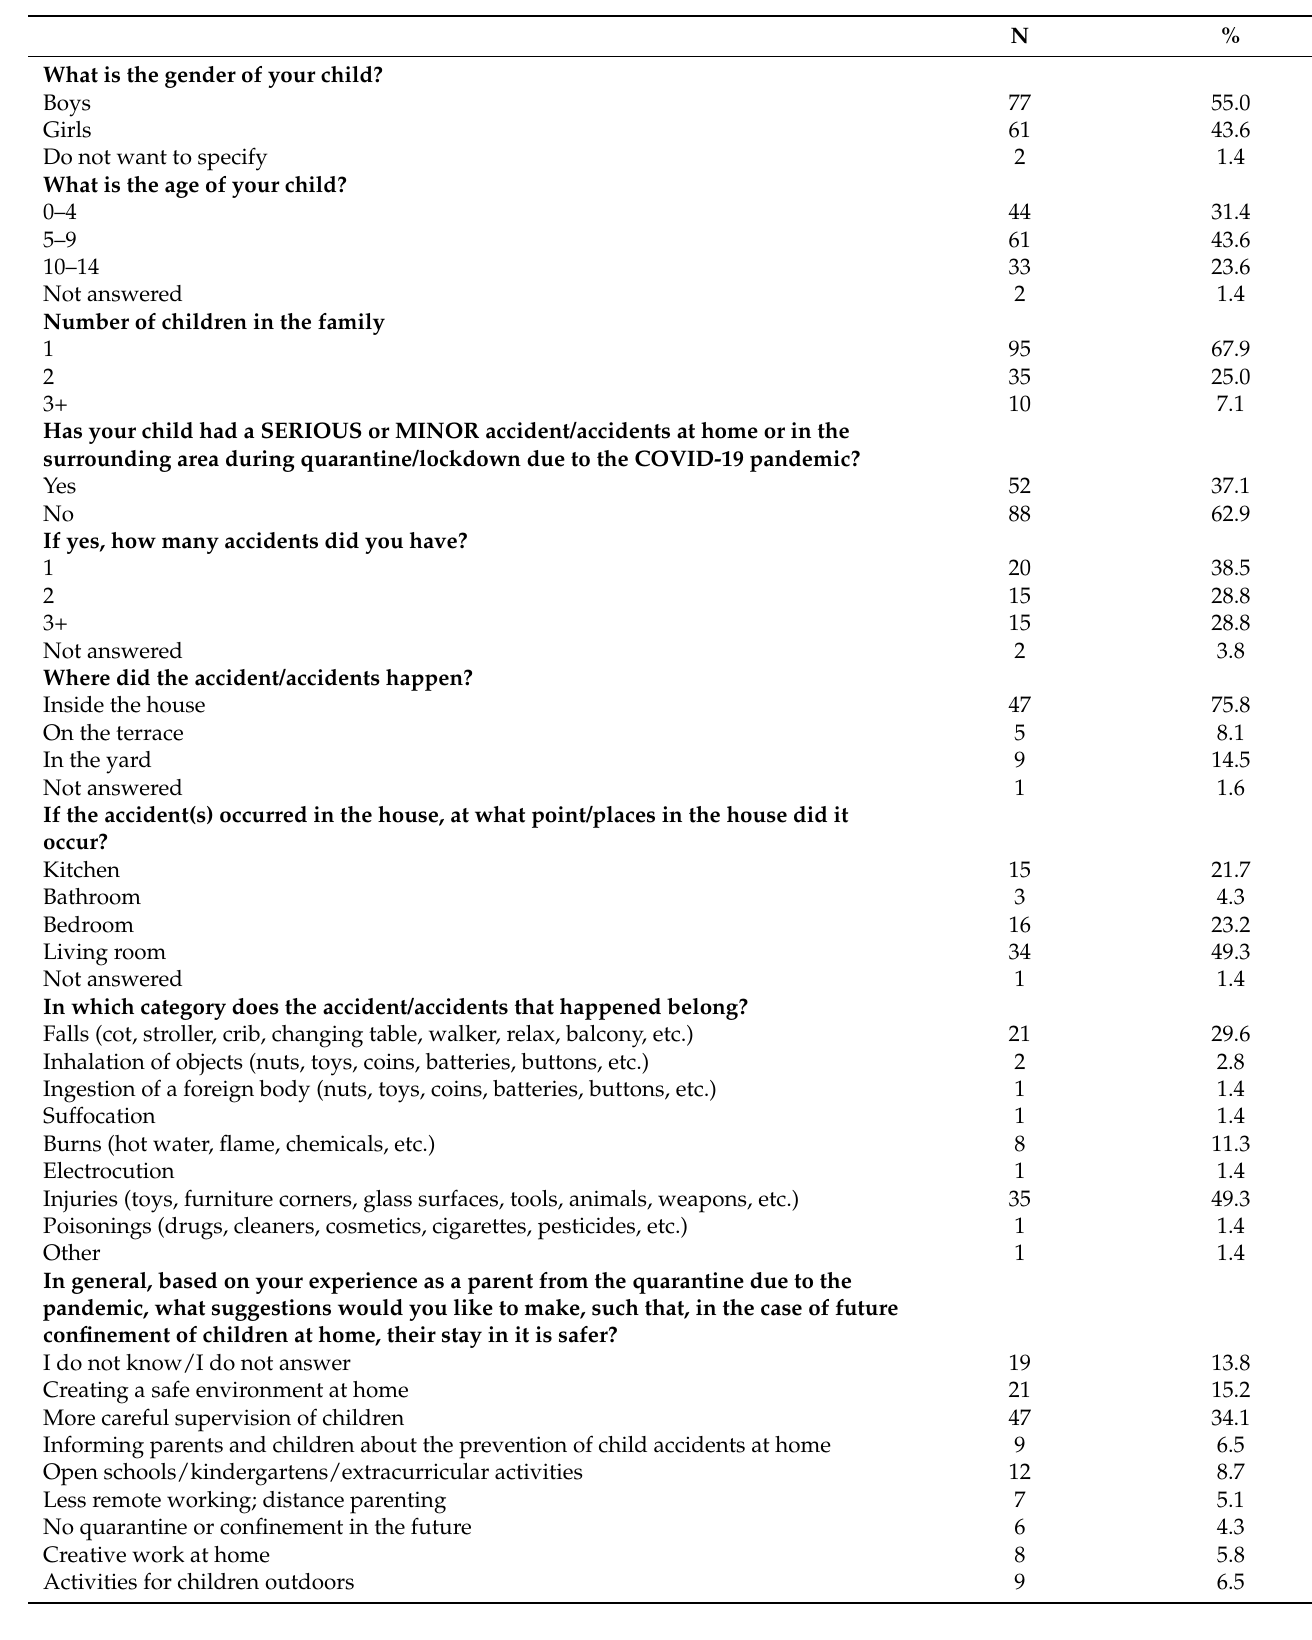
Table 2. Socio-demographic characteristics of the children and information concerning children’s